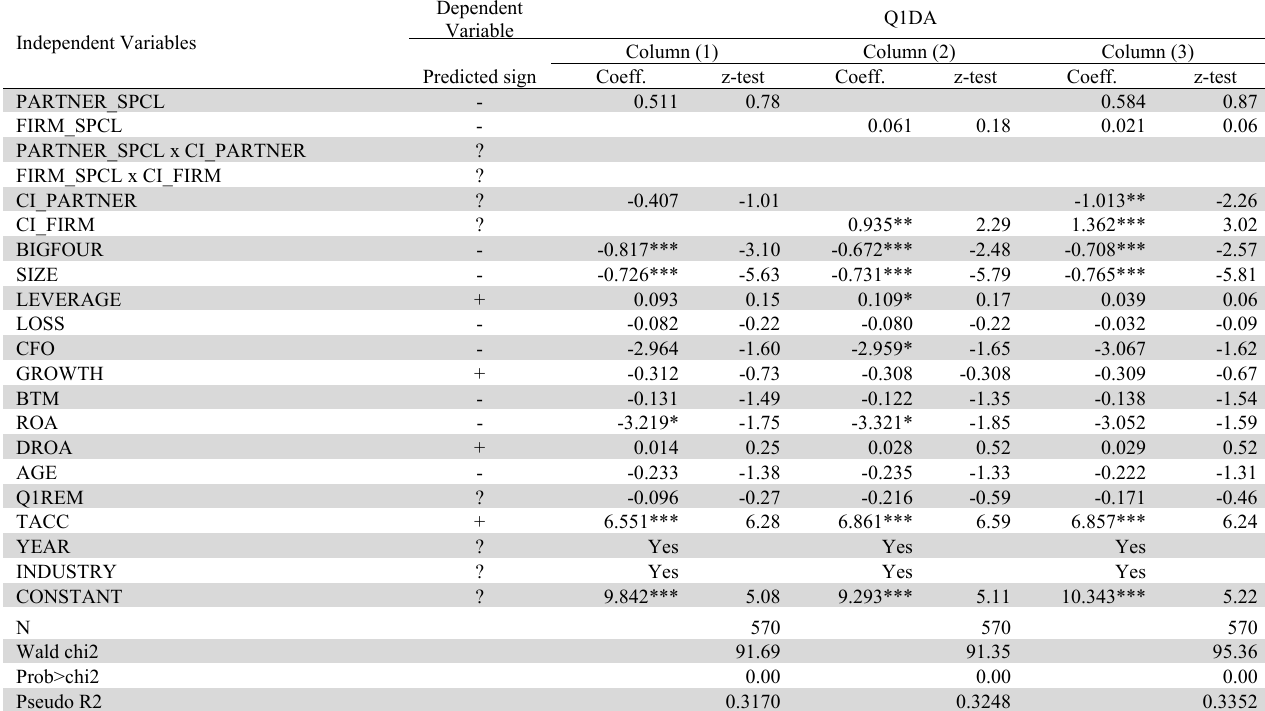
Logistic regression results of H1a and